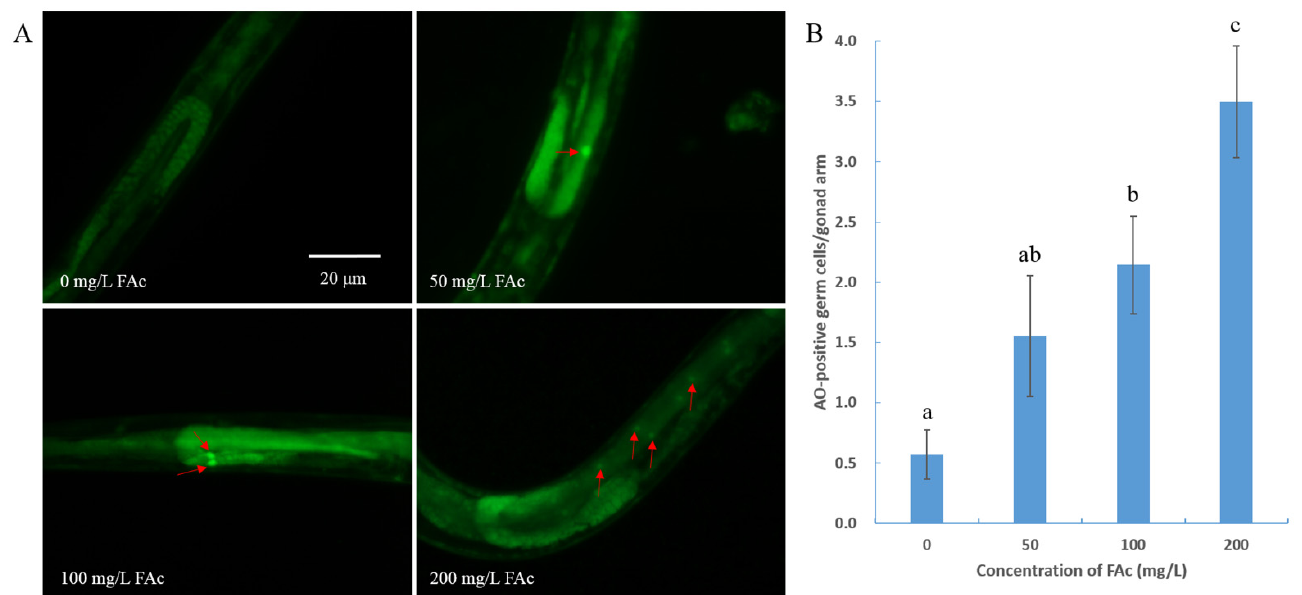
Figure 4. FAc exposure induced the germ-cell apoptosis of C. elegans . ( A ) Images of germ cells of C. elegans , wild-type young adult worms were treated with FAc in different concentrations for 24 h and stained by using acridine orange (AO). Red arrows indicated apoptotic germ cells. The bar denotes 20 μ m. ( B ) Number of apoptotic germ cells of C. elegans after exposure to FAc for 24 h. Data are shown as the mean ± standard error ( n ≥ 7), and different lowercase letters indicate significant difference among treatments by LSD test ( p < 0.05).